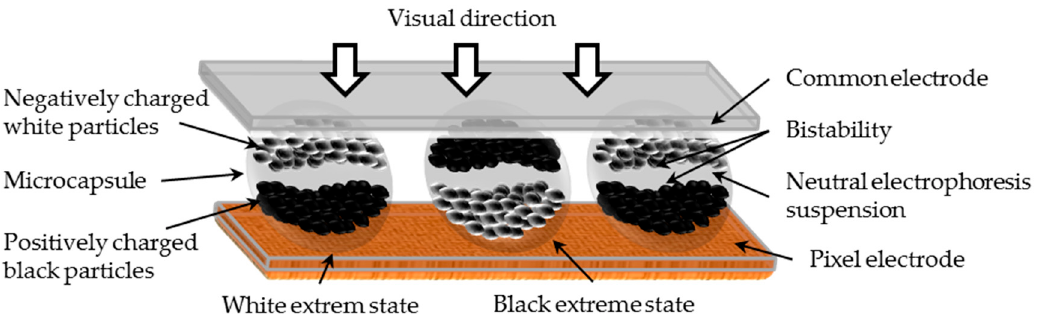
Figure 1. Schematic of an electrophoretic display (EPD) structure. The bottom is the pixel electrode, the middle is the microcapsule which includes a neutral electrophoresis suspension and white and black electrophoretic particles, while the top is the common electrode. The spatial position of particles cannot be changed after the removal of the pixel electrode voltage, which is referred to as bistability.